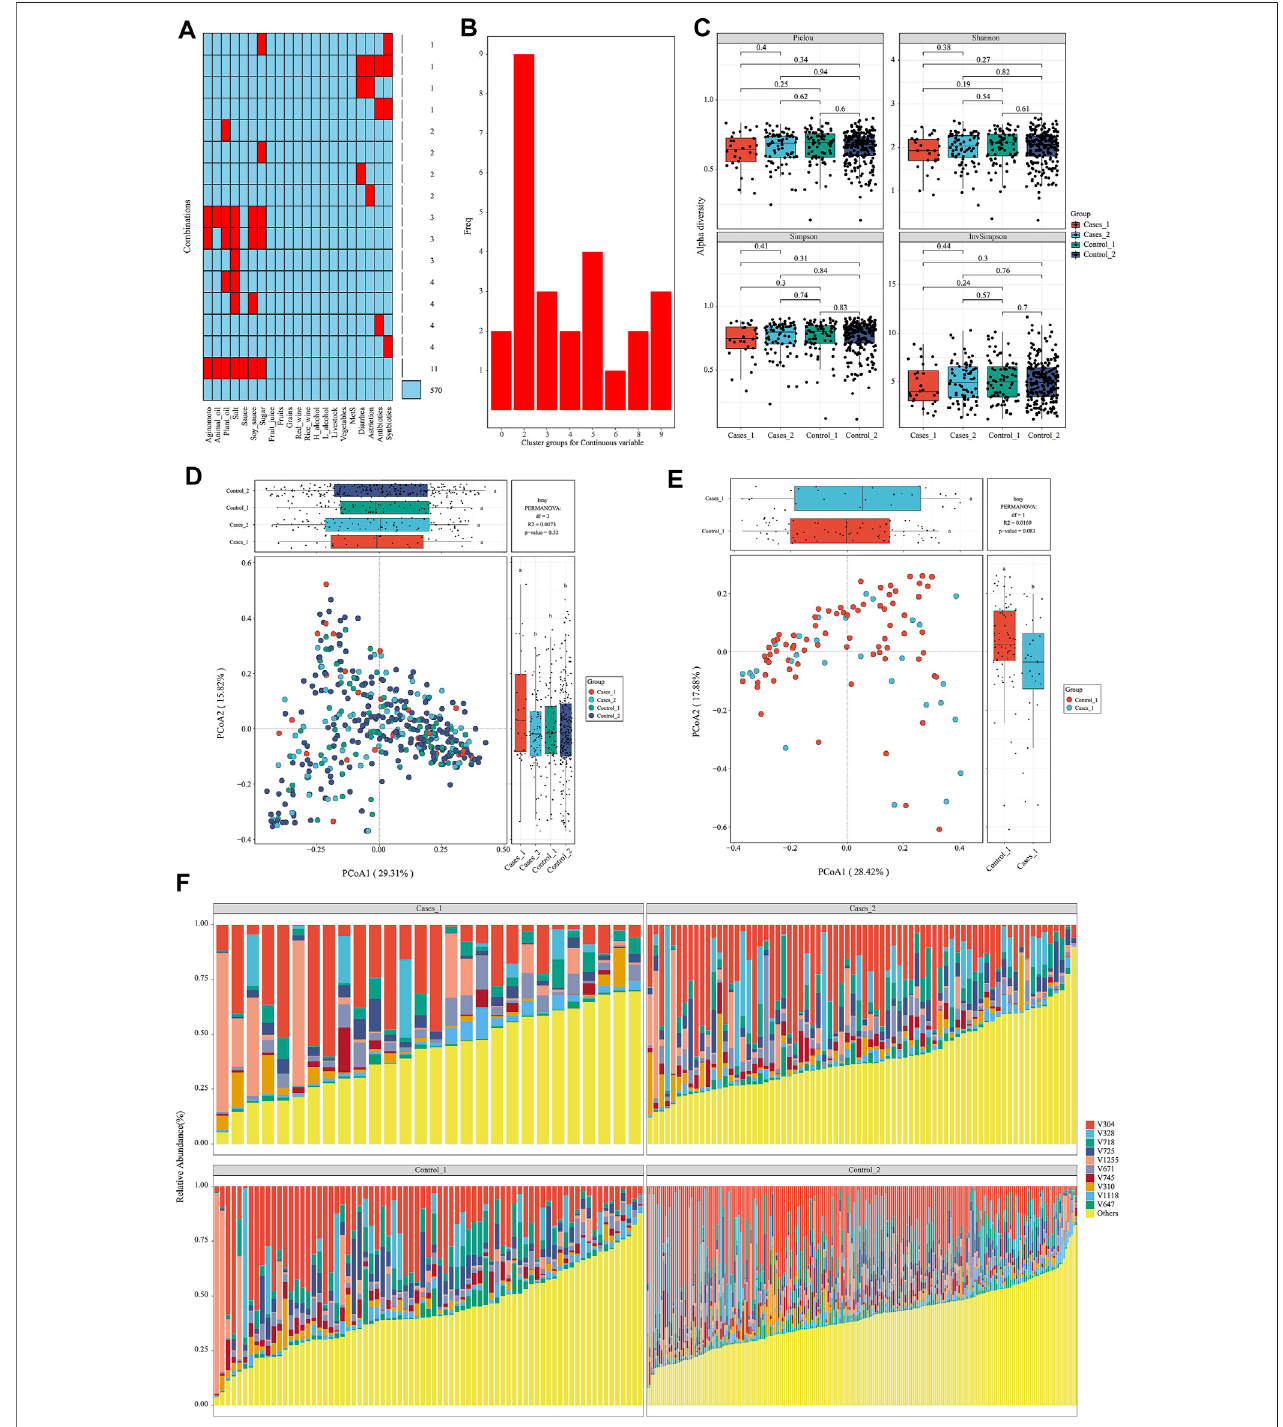
FIGURE 2 | Diets are associated with signi fi cantly structural changes of gut microbiota. (A) The distribution of missing value in the meta data. (B) Twenty-six estimate indices vote for the best cluster number based on dietary structure. (C) α -Diversity on Pielou, Shannon, Simpson, and InvSimpson index among different subgroups. (D,E) β -DiversityonBray – CurtisindexandpermutationalMANOVAtestamongdifferentsubgroupswithconsiderationofdietarystructure. (F) Thestructure plot for top 10 gut bacterial taxa.